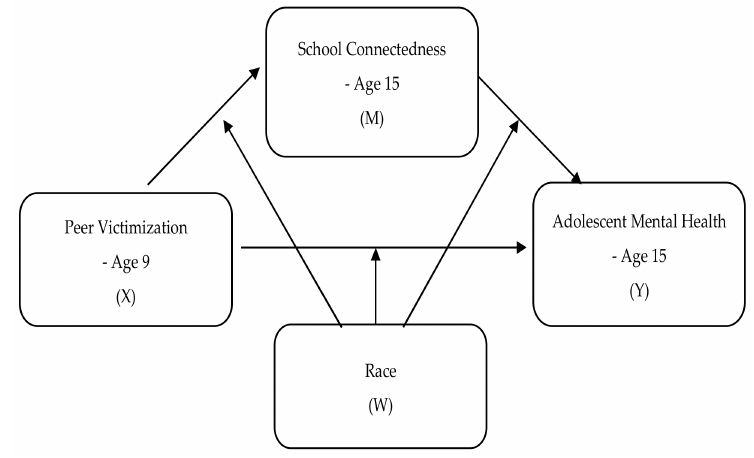
Figure 1. Proposed moderated mediation